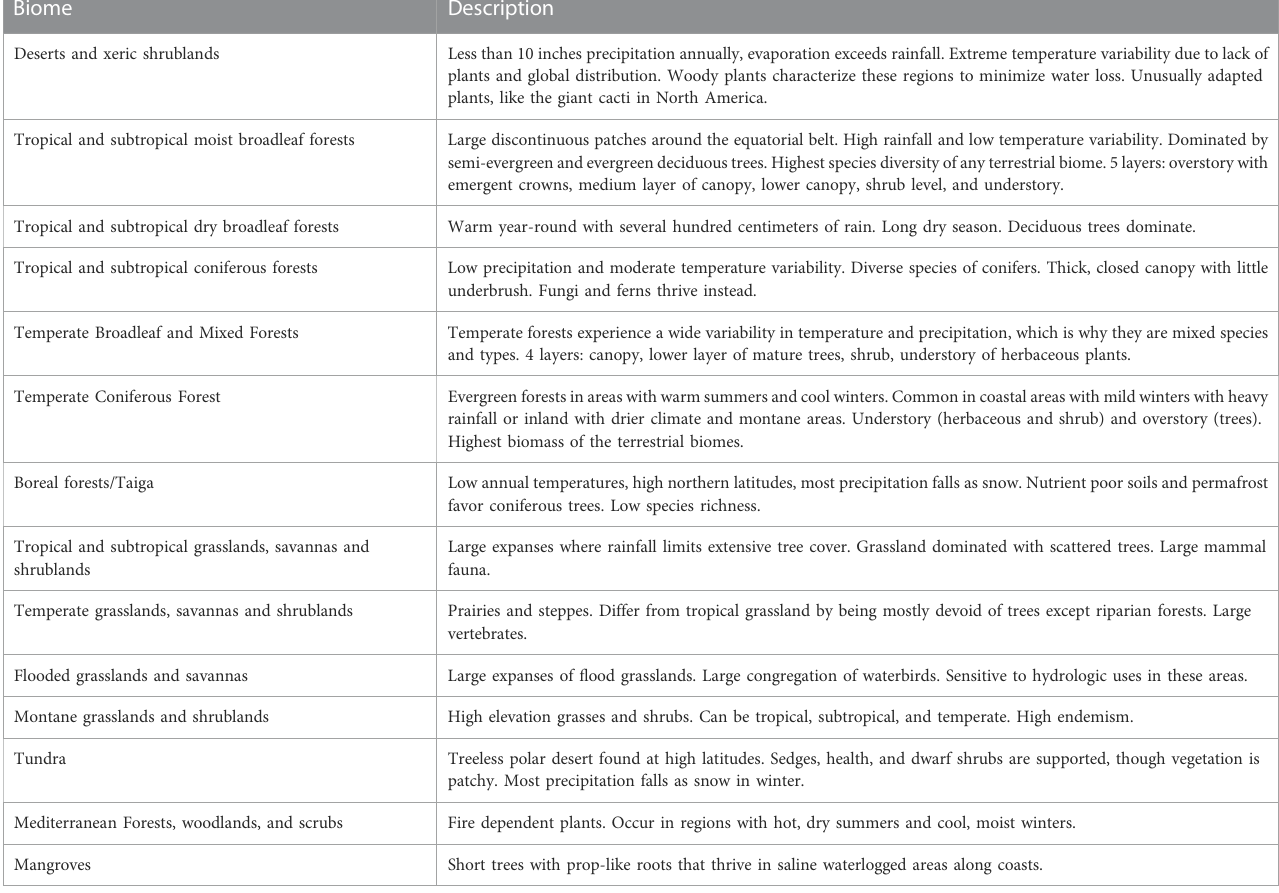
TABLE 1 Global biomes used for analysis and their descriptions, from the WWF (2020). Biome